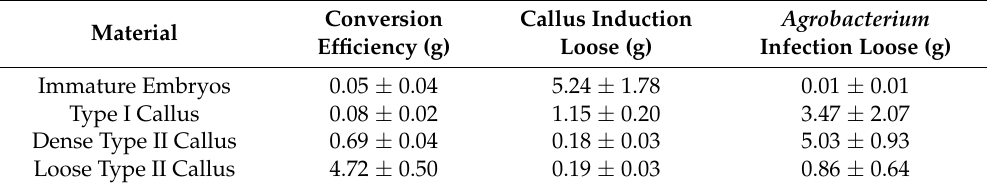
Table 2. The conversion efficiency and loose causes in different types of receptor materials.